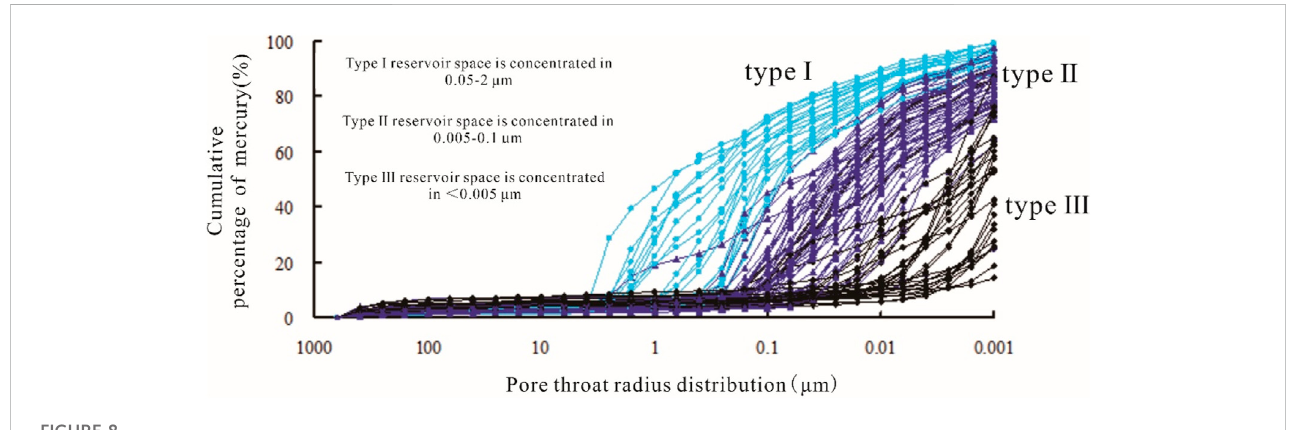
FIGURE 8 Characteristics of the pore throat radius of the Gaotaizi reservoir in the Qijia Area.